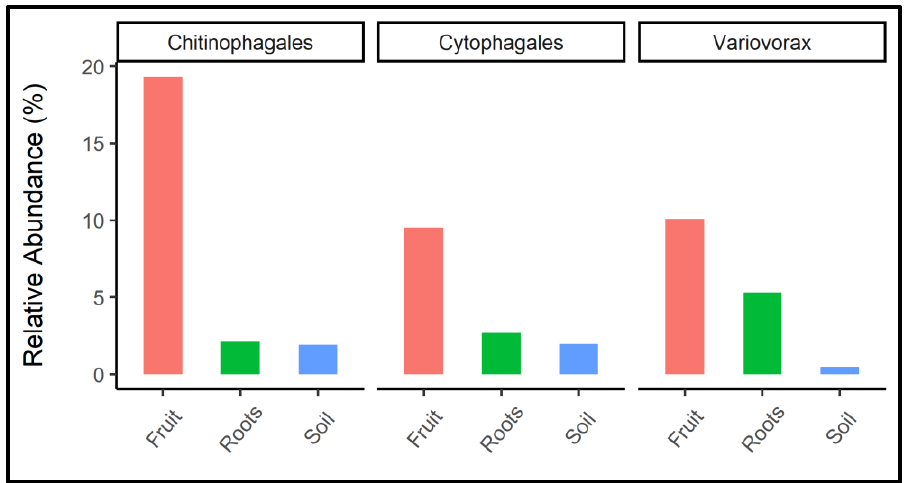
Figure 5. Relative abundance of fruit-associated bacterial groups was found as biomarkers using the LEfSe analysis.